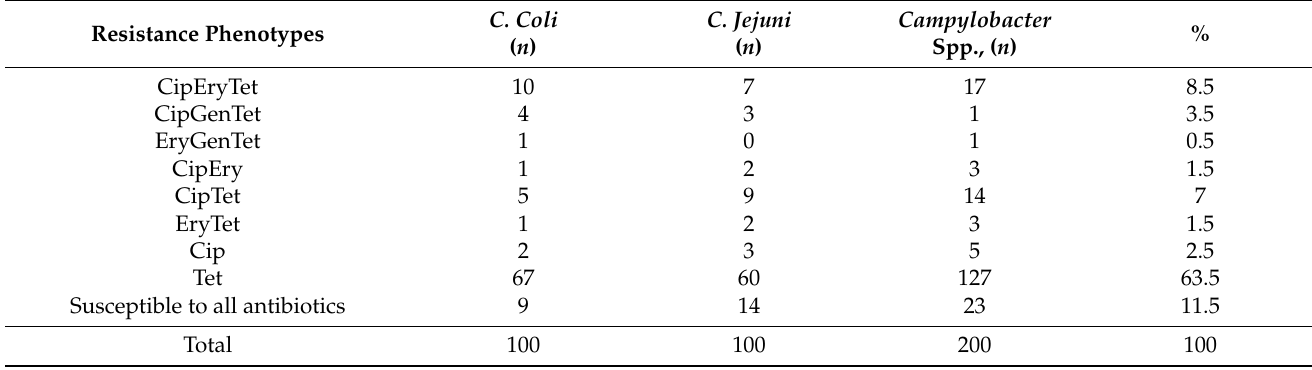
Table 2. Antimicrobial resistance